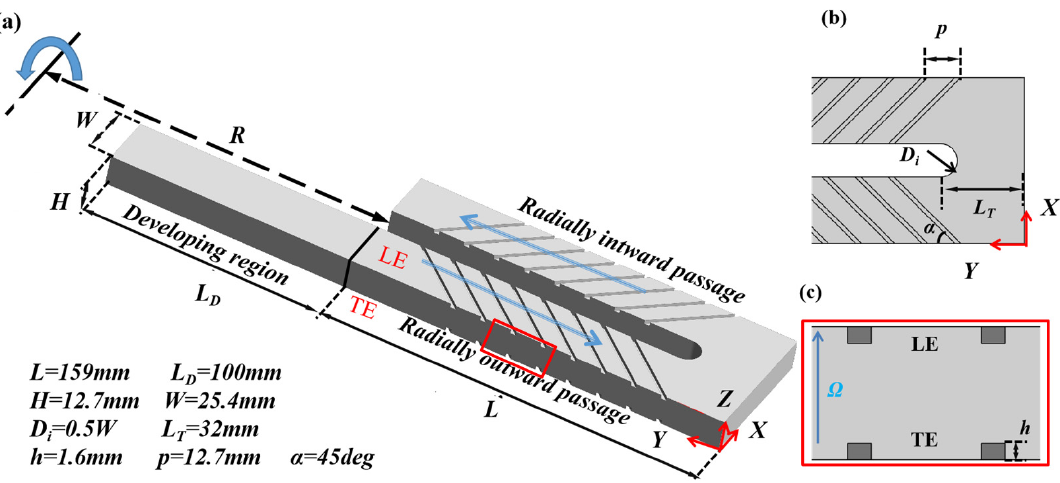
Figure 2. Geometries of ( a ) whole channel ( b ) tip turn region and ( c ) ribs.